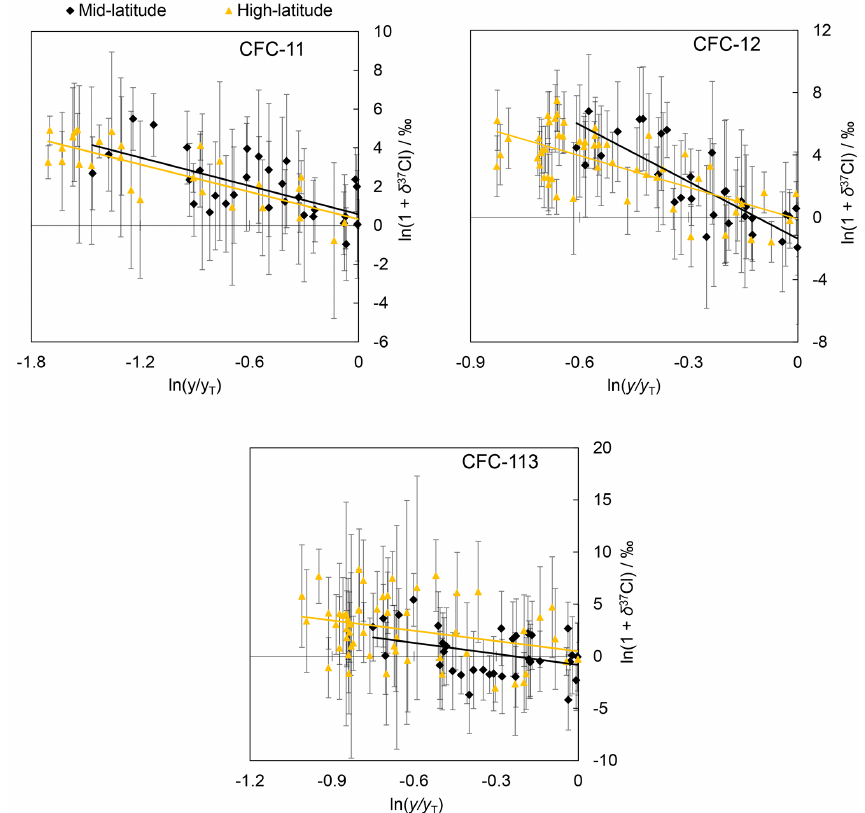
Figure 1. Rayleigh fractionation plots of CFC-11, CFC-12 and CFC-113 chlorine isotope signatures, derived from mid-latitude (black diamonds) and high-latitude (orange triangles) stratospheric samples. Trend lines correspond to apparent fractionations ( ε app ) of − 2.4 (0.5) and − 2.3 (0.4)‰ (CFC-11), − 12.2 (1.6) and − 6.8 (0.8)‰ (CFC-12) and − 3.5 (1.5) and − 3.3 (1.2)‰ (CFC-113) for mid- and high latitudes, respectively. The standard error of the gradient is quoted for ε app values. The average repeatability for individual samples was ± 2.3‰ (CFC-11), ± 2.4‰ (CFC-12) and ± 3.9‰ (CFC-113). 1 σ standard deviation error bars are shown and rejected measurements are not